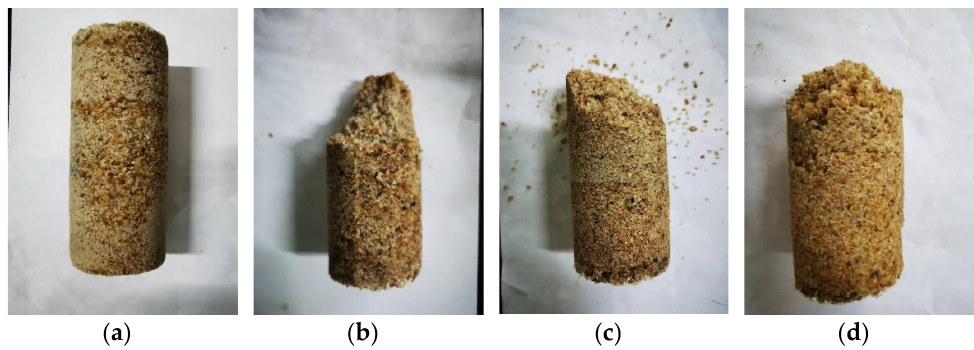
Figure 6. Morphology of sand samples. ( a ) Complete sand column sample. ( b ) Damaged morphology of sand column sample without nucleating agent added. ( c ) Damaged morphology of sand column sample with added sucrose. ( d ) Damaged morphology of sand column sample with added sorbitol.